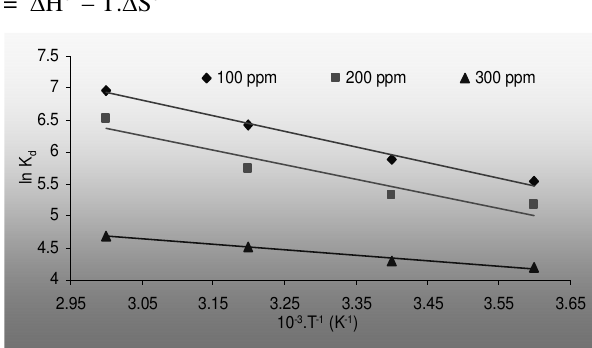
Figure 6. Effect of temperature on thermodynamic behavior of sorption of Cu +2